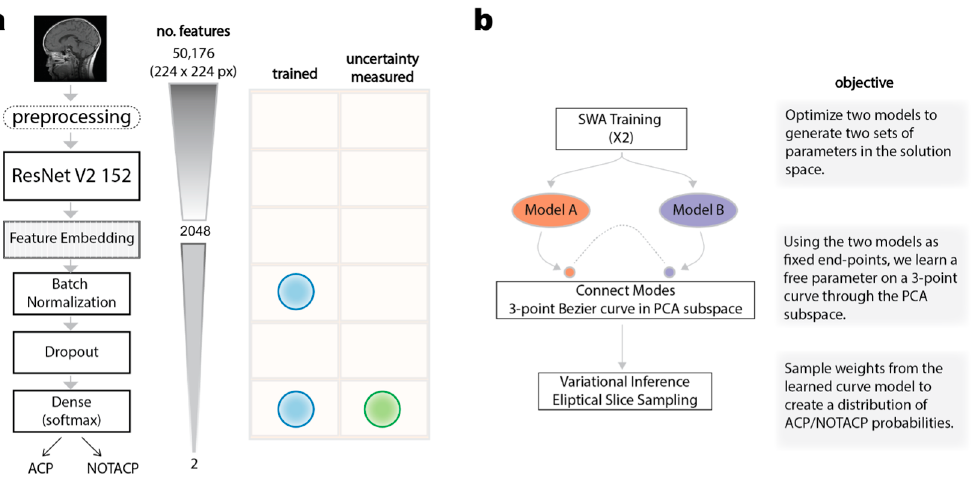
Figure 1. Overview of deep learning model architecture ( a ) and calibration approach ( b ).